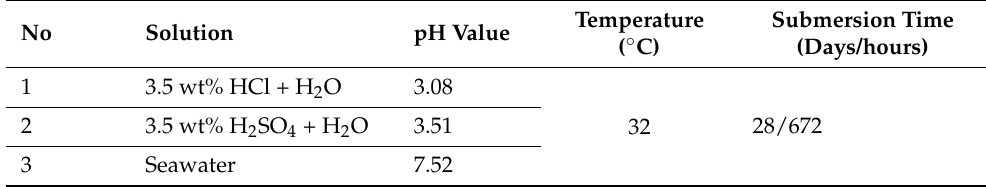
Table 4. Submersion test media and their details.